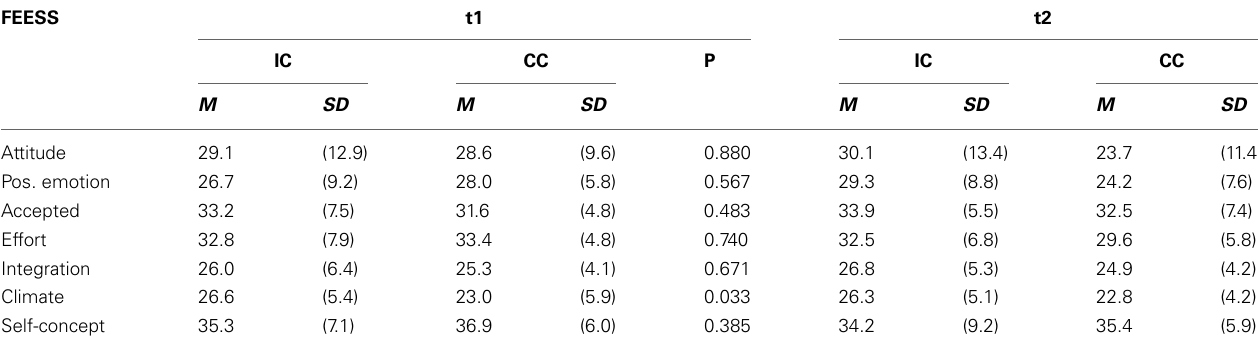
Table 1 | Mean and standard deviation of FEESS for intervention-class (IC) and control class (CC) at t1 and t2 plus p -value of t -tests for differences between groups at